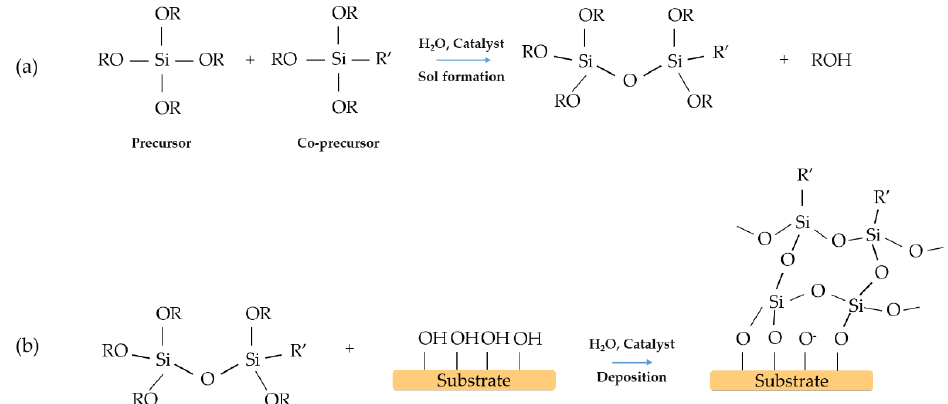
Figure 7. Representation of ( a ) crater-like morphology, ( b ) needle-like morphology.